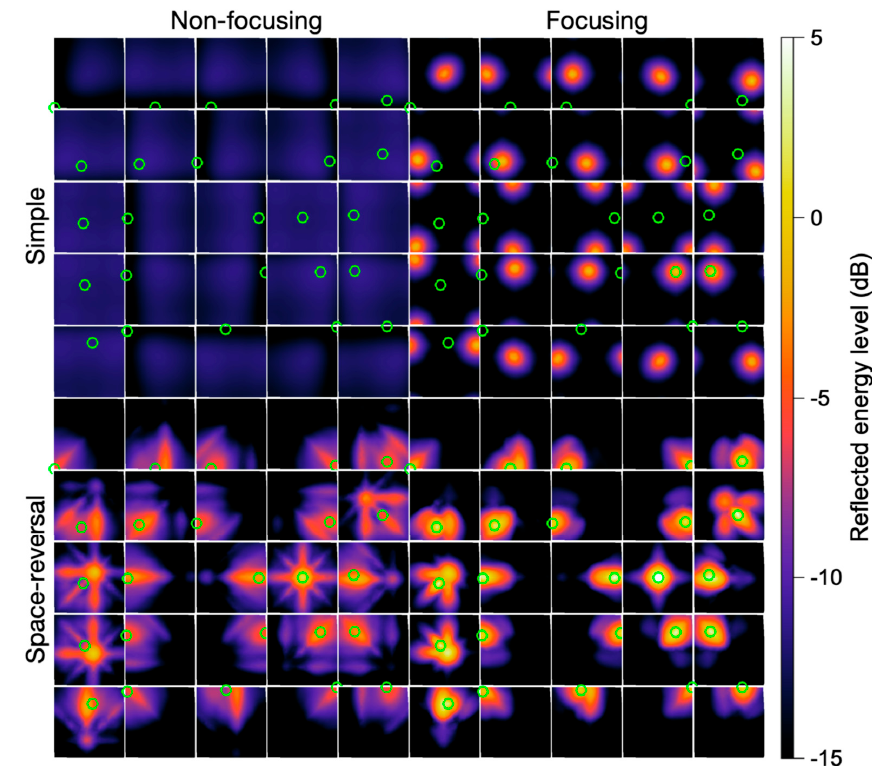
Figure 13. Spatial distribution of reflected energy level over a 2.4 × 2.4 m square for 25 source positions 2 m from the 2.4 × 2.4 m reflector, comprising four 1.2 m patches. The top left quadrant shows the simple reflector; the top right quadrant shows a focusing array; the bottom left quadrant shows the 1.2 m space-reversal array; and the bottom right quadrant shows the focusing space-reversal array. Source locations are indicated by the green circles. Values are speech-A-weighted.